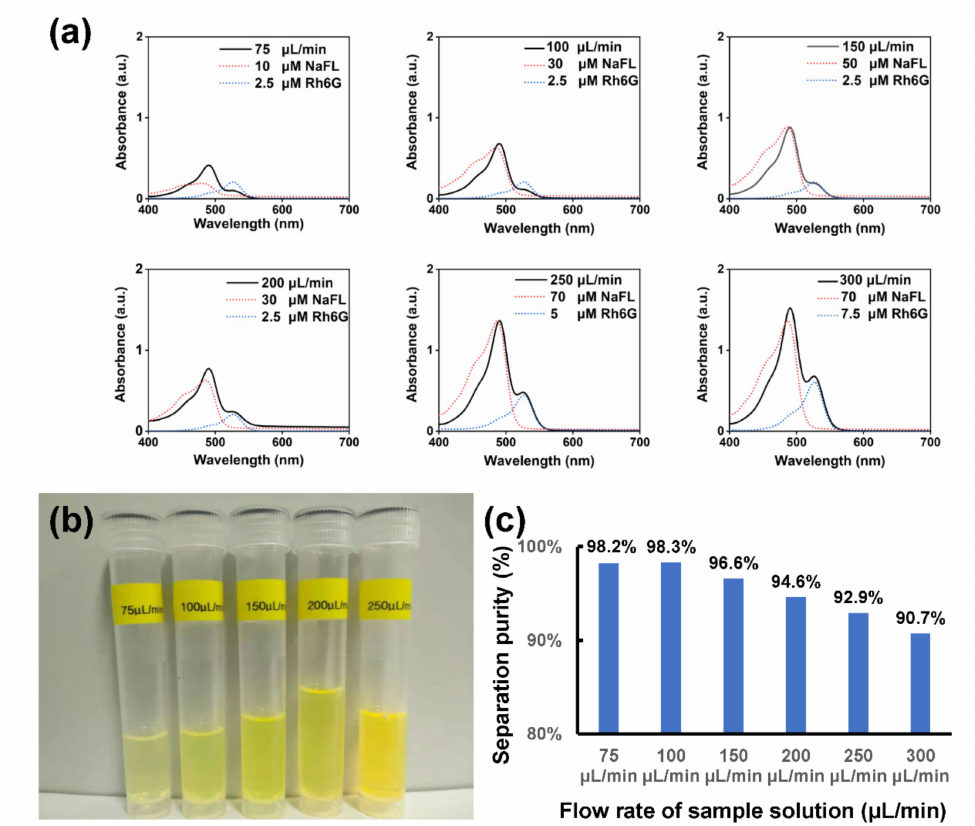
Figure 6. ( a ) Absorption spectra (solid curves) of the products collected from outlet 1 (near the positive electrode) with different flow rates of the sample solutions ranging from 75 µ L/min to 300 µ L/min. Blue and red dashed curves are absorption spectra of the Rh6G solution and the NaFL solution with different concentrations for reference, respectively. ( b ) Photo of the products collected from outlet 1 (near the positive electrode) with different flow rates of the sample solutions. ( c ) Estimated separation purity versus flow rate of the sample